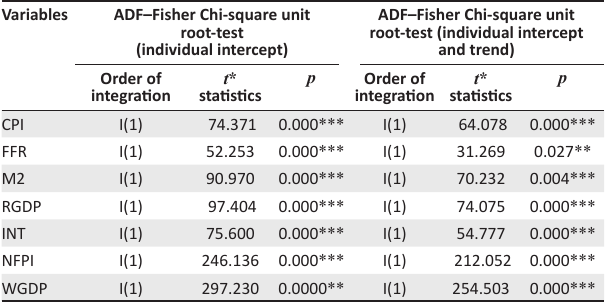
TABLE 1c: Levin, Lin and Chu, Im, Pesaran and Shin and Augmented Dickey– Fuller unit root tests. Variables